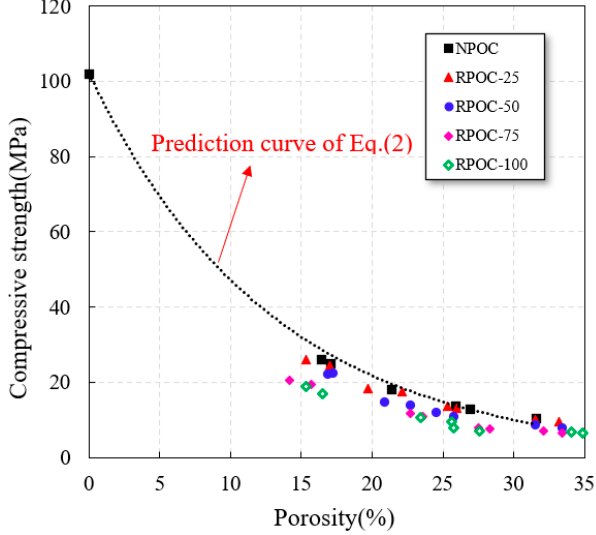
Figure 9. Relationship between actual compressive strength of various types of porous concrete and calculation curve of Equation (4).